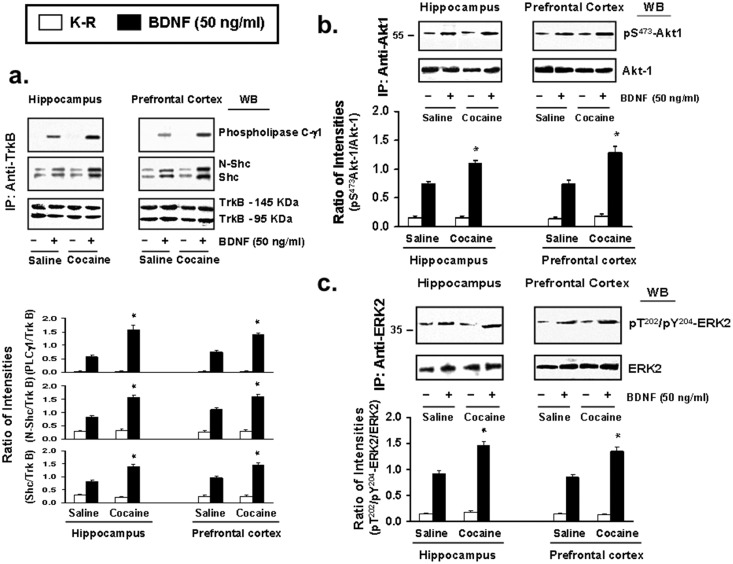
Prenatal cocaine increases BDNF-induced phospholipase C-γ1, Shc and N-Shc recruitment to the activated TrkB as well as downstream PI3K and ERK2 activation in hippocampus and PFCX.(a) Prenatal cocaine exposure increased 50 ng/ml BDNF-induced recruitment of the downstream signaling molecules phospholipase C-γ1, and adaptor proteins, Shc and N-Shc to activated TrkB in hippocampus and PFCX. Western blots of phospholipase C-γ1, N-Shc, and Shc as well as TrkB that served as the loading control were analyzed by densitometric quantification. Data are means ± s.e.m. of the ratios of phospholipase C-γ1, N-Shc, or Shc to TrkB optical intensities. n = 6 (3 males and 3 females). Prenatal cocaine exposure also enhanced PI3K and ERK signaling downstream of TrkB in hippocampus and PFCX as evidenced by the Western blot detection of increased activated (pS473)- Akt1 (b, top) and (pT202/pY204)-ERK2 (c, top). Densitometric quantification of blots is shown in the bottom of the representative blot. Data are means ± s.e.m. of the ratios of pS473-Akt1/Akt1 (b, bottom) and pT202/pY204-ERK2/ERK2 (c, bottom) optical intensities. n = 6 (3 males and 3 females). *p < 0.01, compared to respective protein in the saline-treated group.